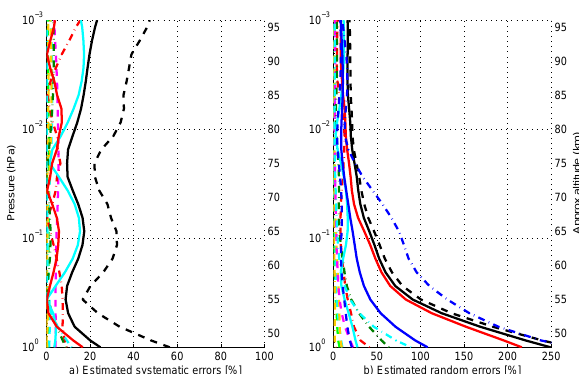
Fig. 6. In (a) the estimated systematic errors and in (b) the ran- dom errors. The colored (except blue) lines show the mean rela- tive change (a) and standard deviation (b) in the retrieved value at each altitude as the different forward model parameters are per- turbed. The forward model parameters are: line-strength, I 0 , (green- dashed), temperature profile, T , (cyan-dashed), pressure broaden- ing parameter, γ P , (yellow-dashed), temperature coefficient for the broadening parameter, α P , (yellow-dashed-dot), a priori profile, x a , (red-dashed-dot), 50% a priori uncertainty, S x , (green-dashed-dot), removing natural variability from a priori uncertainty, S x , (red- solid), a priori uncertainty for the polynomial fit (cyan-dashed- dot), calibration errors (magenta-dashed-dot) and backend channel broadening error (cyan). The black line in both figures is the root- sum-square of the parameter errors. In (a) the black-dashed is the sum of the errors. The dark blue lines in (b) show the retrieval noise from 1 January 2006 (dashed), 2 September 2006 (dashed- dot) scaled with the a priori profile for the respective day as well as the average retrieval noise (solid). The black dashed line in (b) is the root-sum of the average retrieval noise (blue-solid) and the total parameter variability